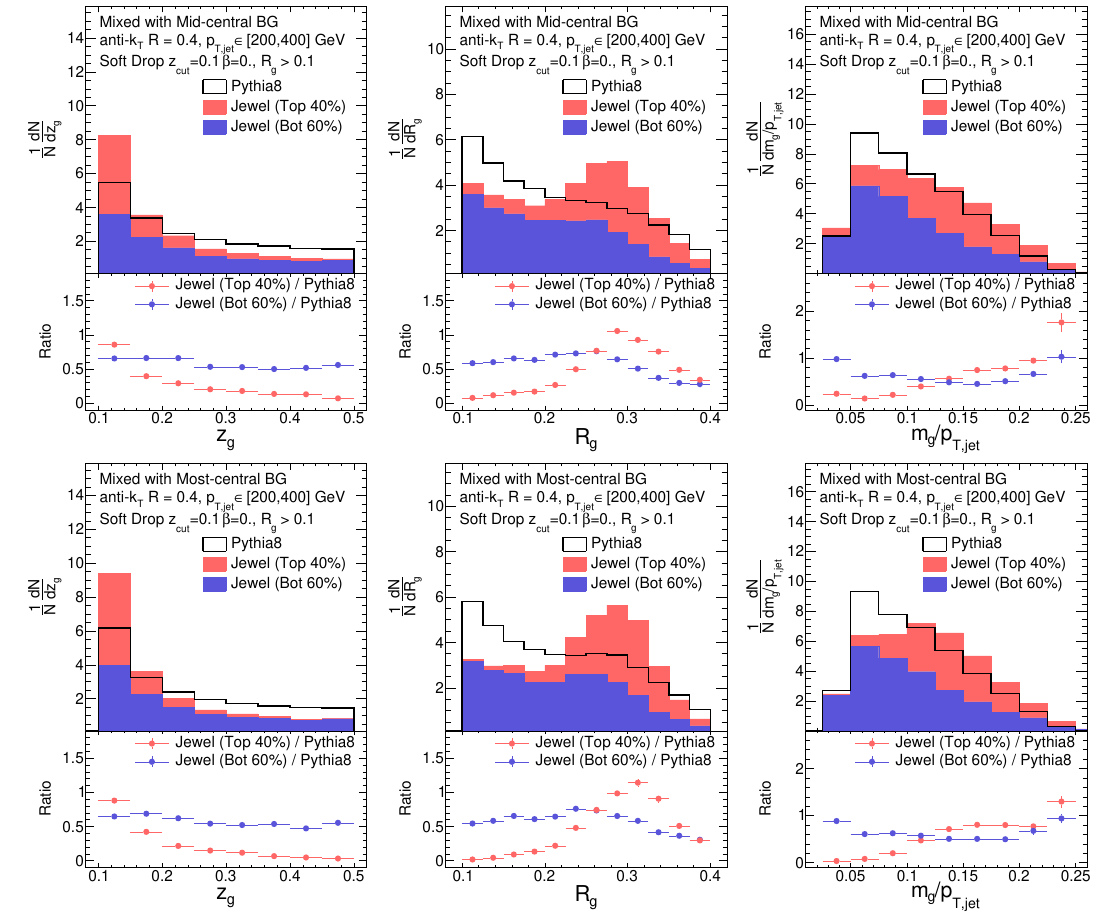
Figure 10 . Distribution of the substructure variables of the groomed jets in the mid-central events (top) and the most-central events (bottom). Samples of the positive class ( Jewel ) are plotted with stacked